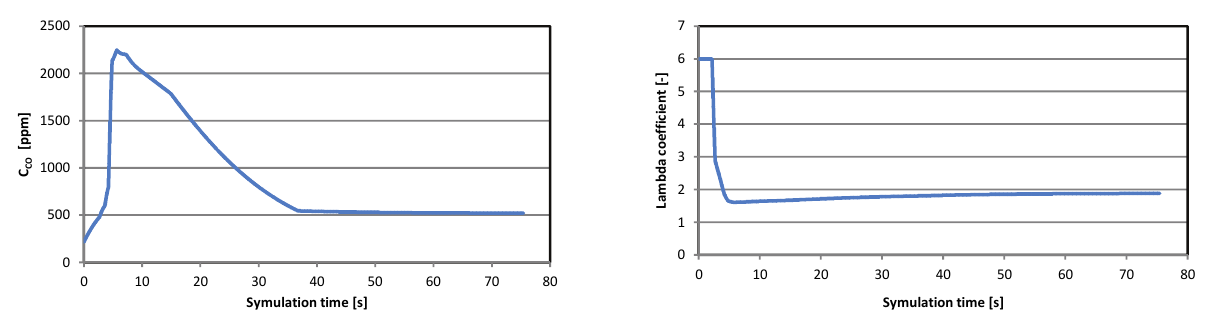
Fig. 10. Lambda coefficient during